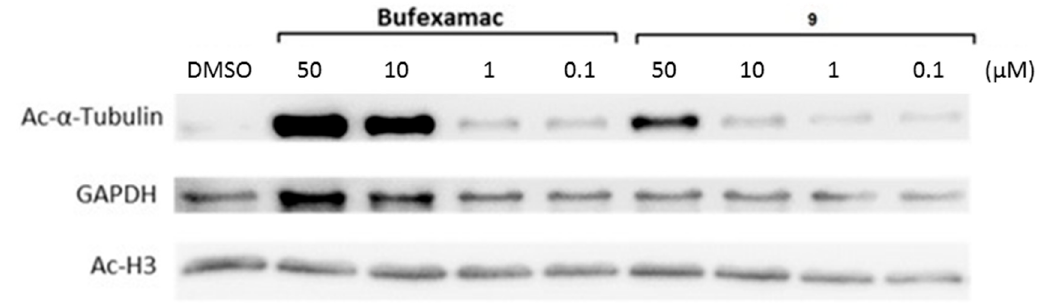
Figure 5. Detection of acetylation levels of H3 and tubulin after incubation of HL60 cells with bufexamac and the carbamate 9. GAPDH was used as a loading control.